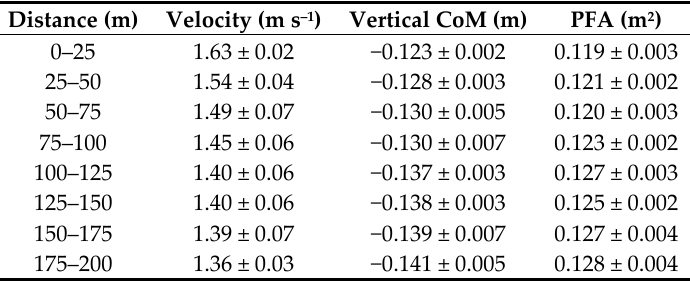
Table 1. Swimming velocity, vertical center of mass (CoM) position, and projected frontal area (PFA) throughout the 200-m front crawl (n = 3).